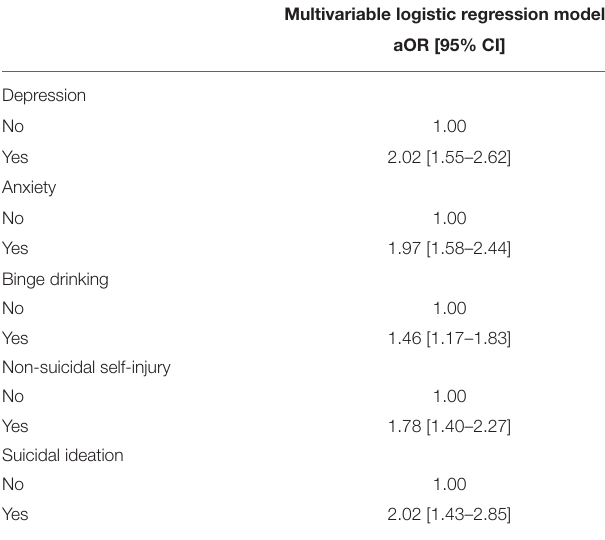
TABLE 2 | Multivariable logistic regression models showing the relations between COVID-19 related racial/ethnic discrimination and mental health outcomes among American/Pacific Islander students from the Healthy Minds Study, September– December 2020.